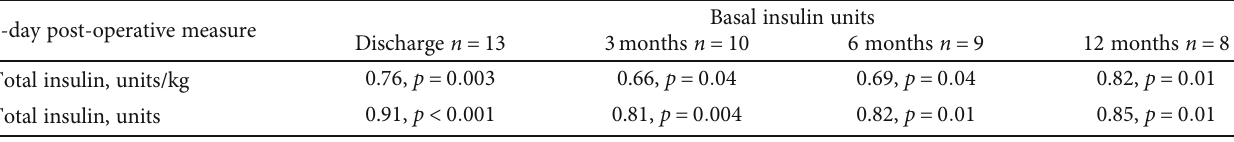
Table 3: Pearson correlation coe ffi cients of 3-day basal insulin with basal insulin requirements at discharge, 3, 6, and 12 months.